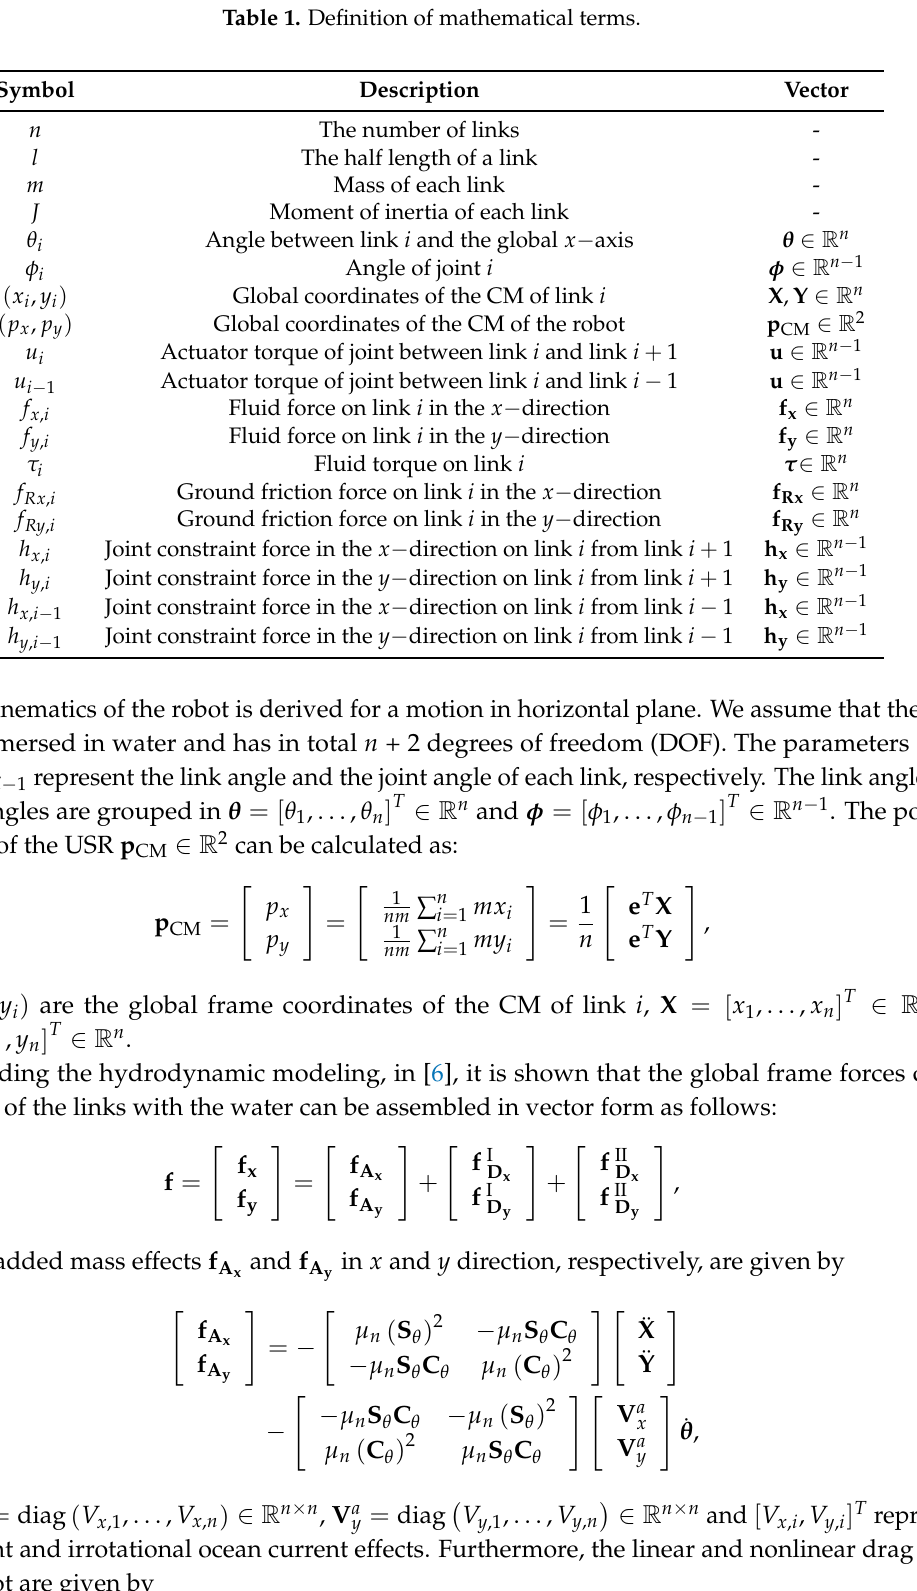
Table 1. Definition of mathematical